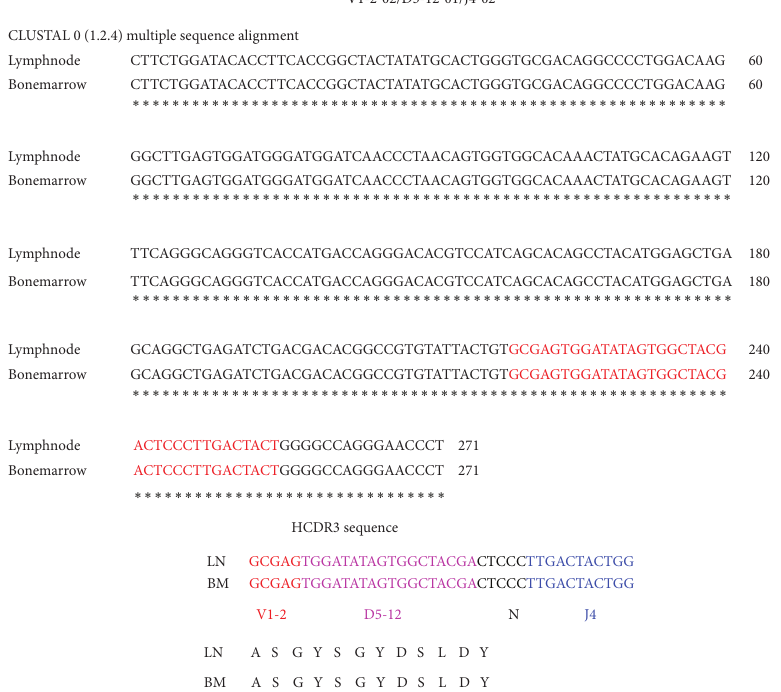
V1-2 ∗ 02/D5-12 ∗ 01/J4 ∗ 02